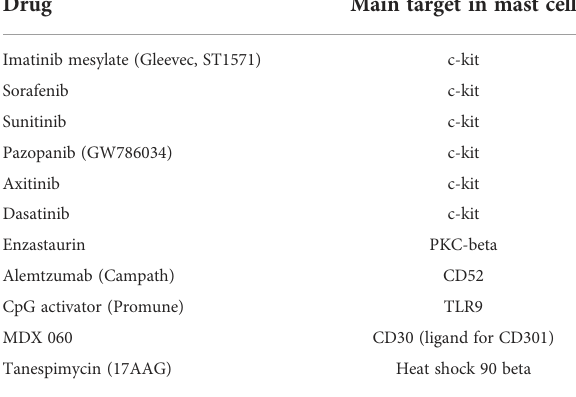
TABLE 1 Anti-tumor drugs that target mast